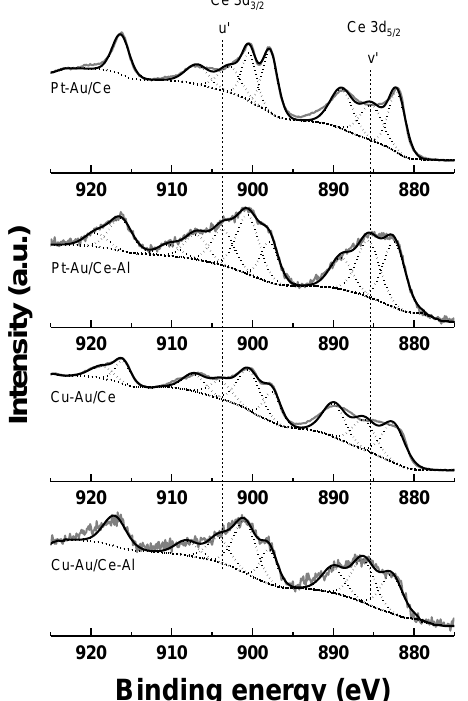
Figure 7. Ce 3d spectra of ceria-containing catalysts.